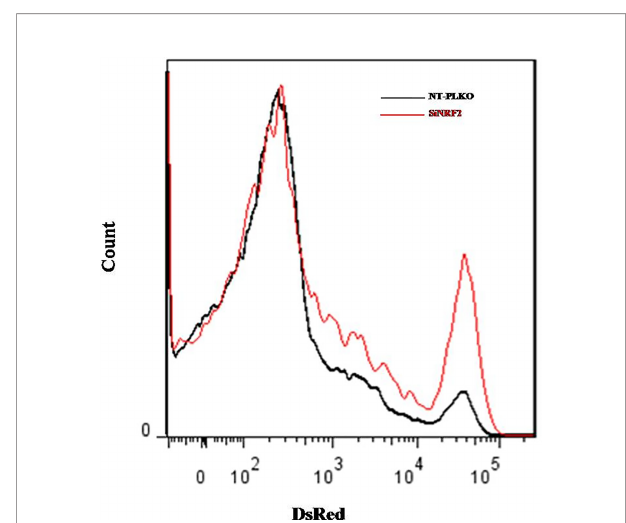
FIGURE 7 | Silencing of NRF2 promoted parasite survival. NT-pLKO or si-NRF2 Raw264.7 cells were infected with Ds-Red promastigotes. Macrophages (M F s) parasitized with Ds-Red parasites were analyzed 72 h post-infection by fl ow cytometry. The percentages of Ds-Red fl uorescence corresponding to the multiplication of amastigotes in parasitized M F s were compared in NT-pLKO and si-NRF2-infected